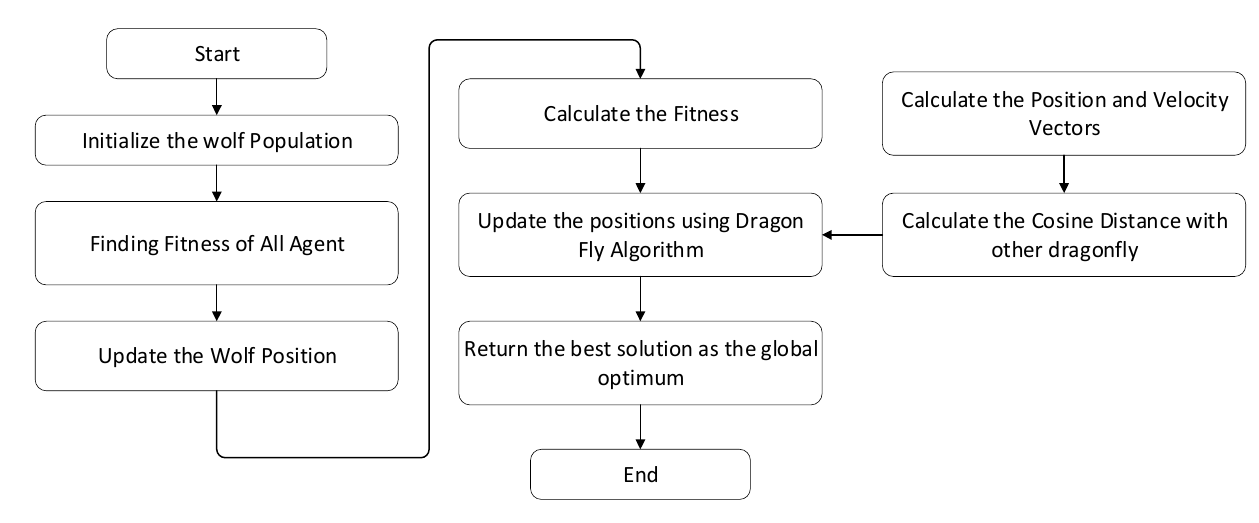
Figure 1. Overall flow of the architecture.